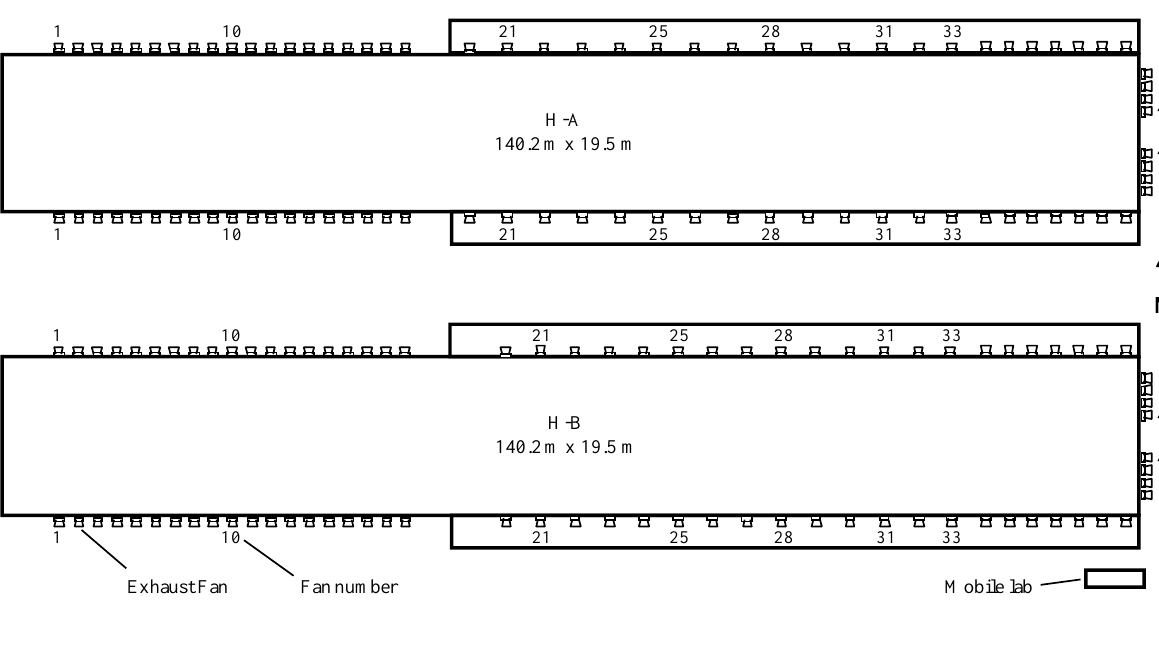
Figure 1. Floor plan of the layer houses (H-A and H-B) and the distribution of ventilation exhaust fans. Numbered fans are variable-speed except for fans 44 in both